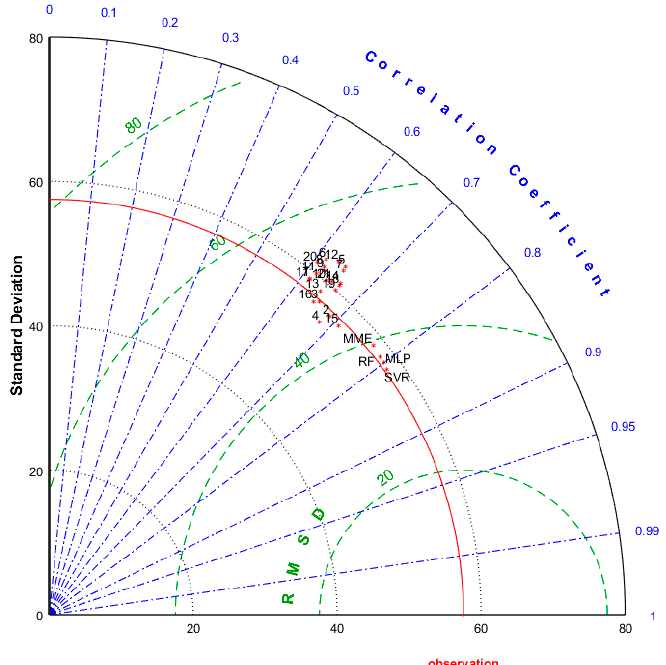
Figure 3. Taylor diagram of single NEX-GDDP models, MME, and machine learning (ML) ensemble models.